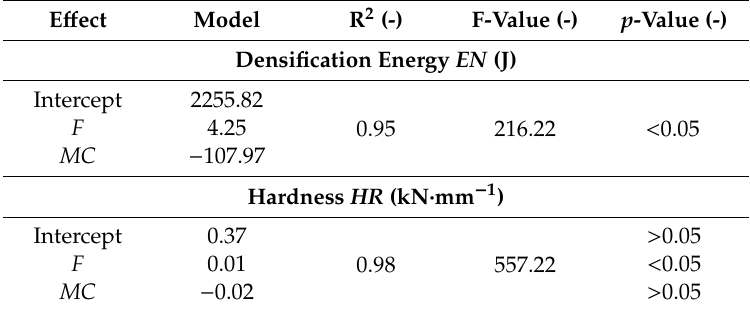
Table 12. Regression results of densification energy and hardness of the ground hazelnut husk briquettes with the e ff ects of force and moisture